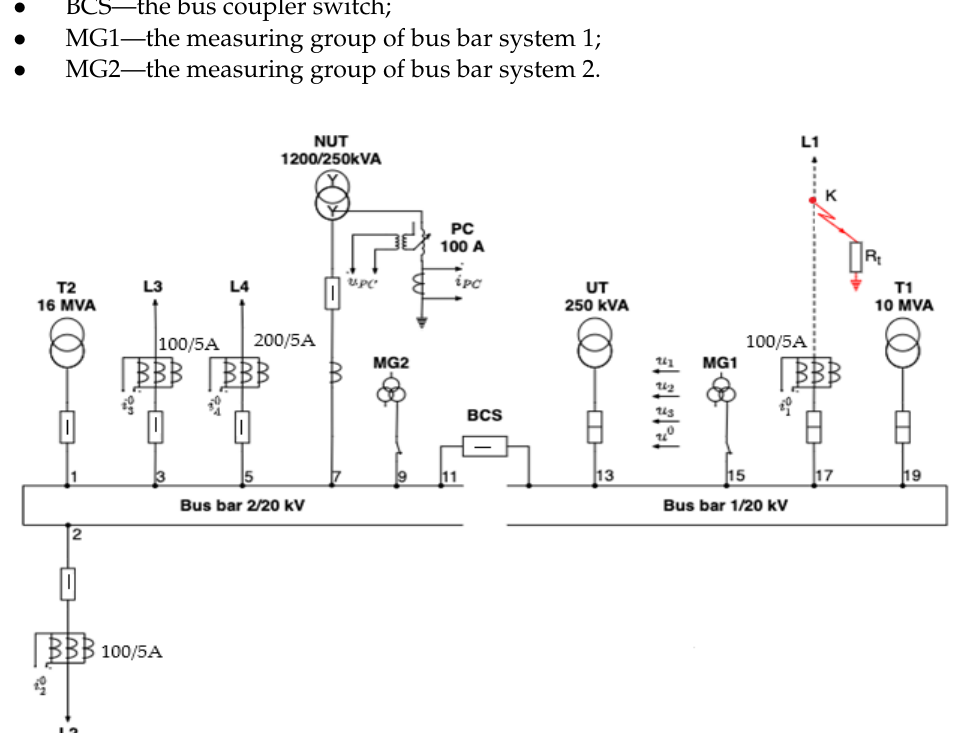
Figure 1. The scheme of the substation and the medium voltage electrical network.